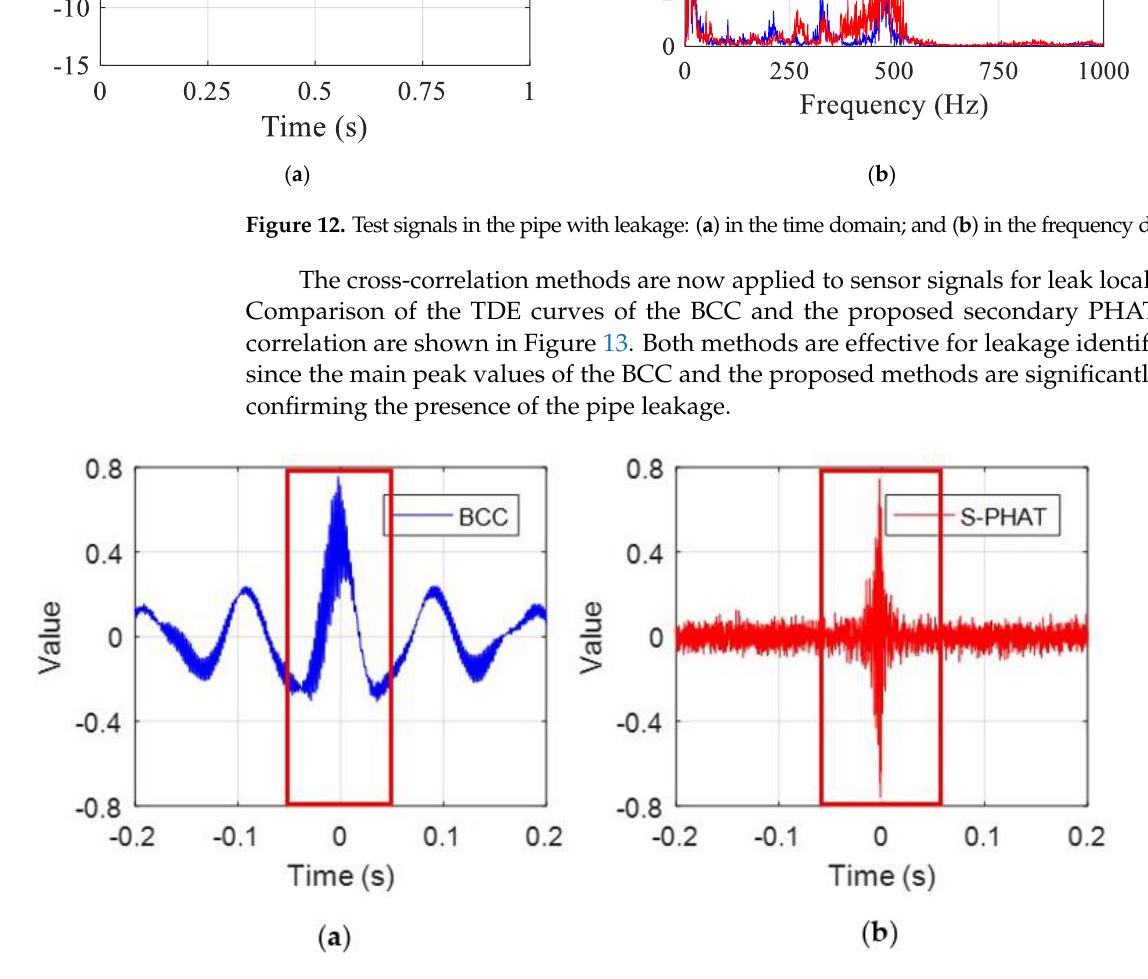
Figure 13. The TDE curves for the test pipe with leakage: ( a ) the BCC method; and ( b ) the secondary PHAT cross-correlation method.